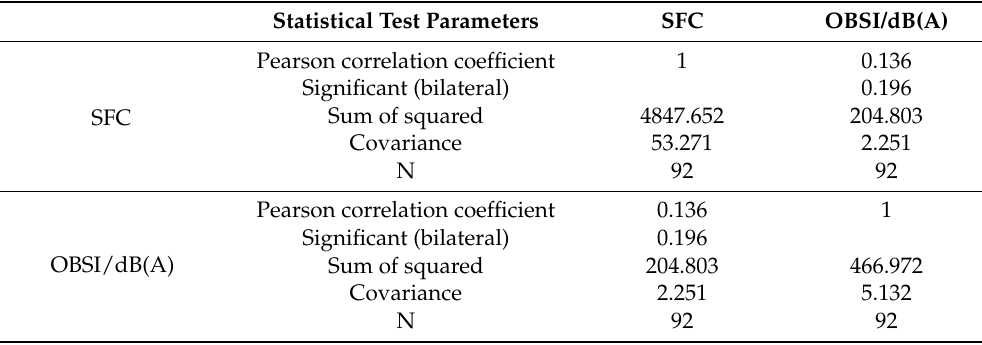
Table 9. Correlation analysis between SFC and